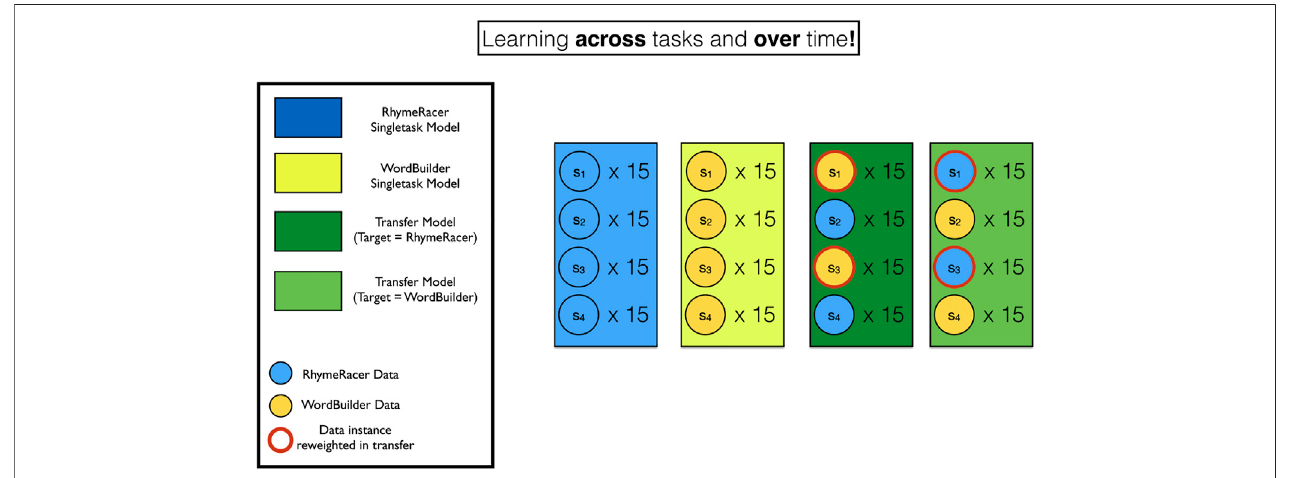
FIGURE 5 | Visual depiction of training data for single- and multi-task student models. Blue and Yellow rectangles and circles indicate models and data instances from R HYME R ACER and W ORD B UILDER . Red rings indicate data has been re-weighted from its originating source task to a new target